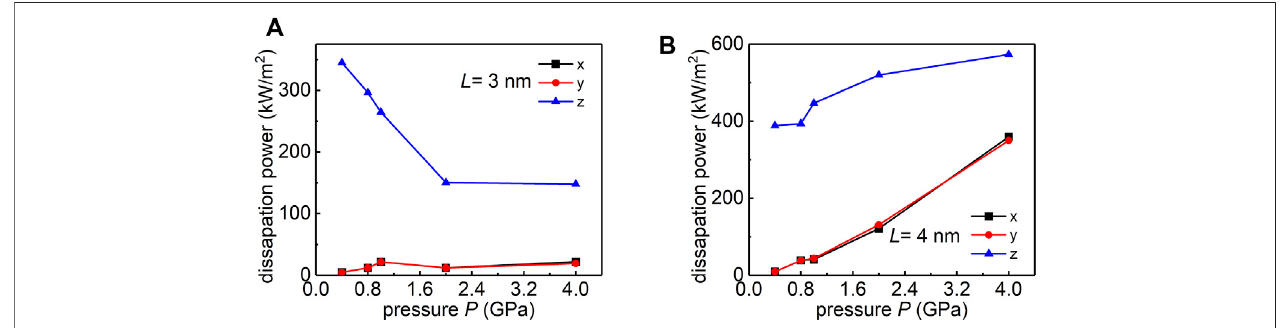
FIGURE 3 | Load dependence of the frictional power dissipated at zero temperature for (A) small loading area case ( L (cid:1) 3 nm), and (B) large loading area case ( L (cid:1) 4 nm).